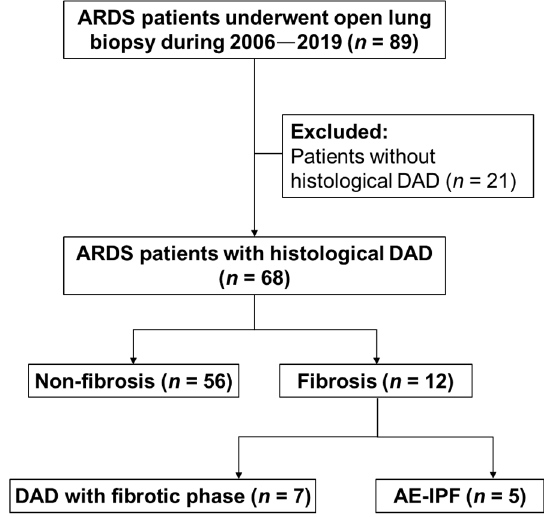
Figure 1. Flow chart of ARDS patients receiving open lung biopsy. ARDS: acute respiratory distress syndrome; DAD: diffuse alveolar damage; AE-IPF: acute exacerbation of idiopathic pulmonary fibrosis.